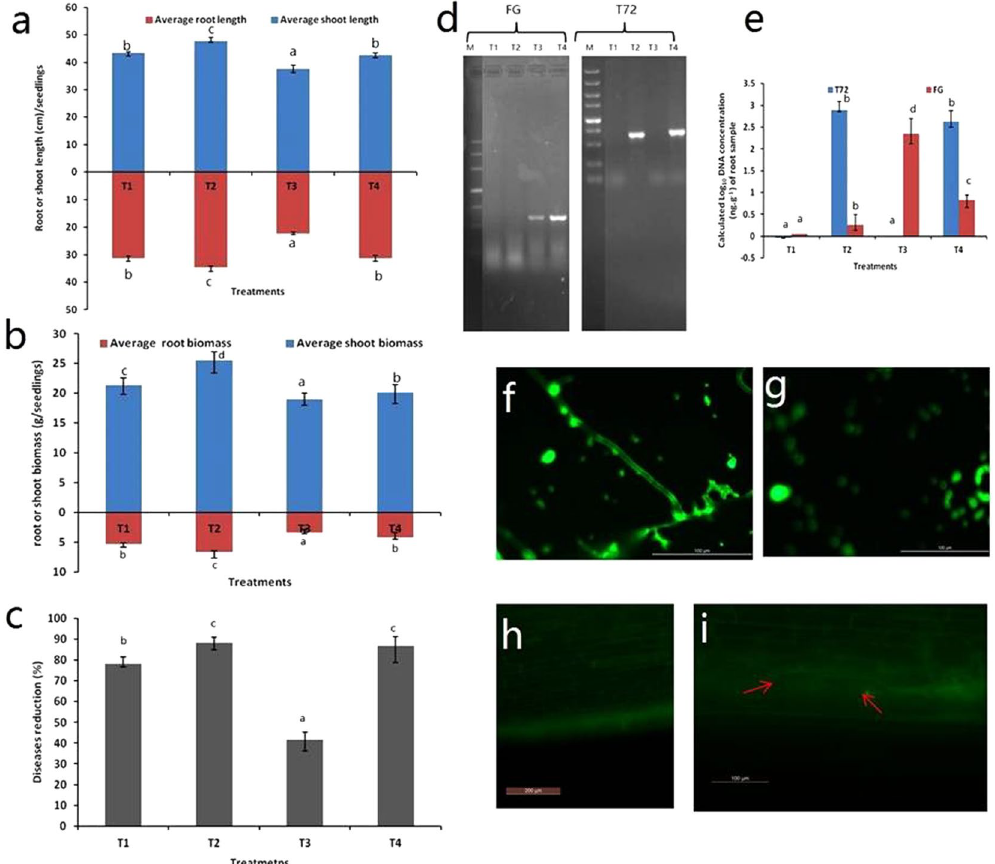
Figure 2. Analysis of physicological indices and root colonization of Trichoderma in maize root by qPCR and eGFP tagged T. harzianum strain CCTCC-RW0024. ( a ) Average root and shoot length (cm/seedlings), ( b ) root and shoot biomass (g/seedlings), ( c ) disease reduction (%), ( d ) electrophoresis representation of T. harzianum strain CCTCC-RW0024 and FG DNA presence in maize root DNA, ( e ) quantification of T. harzianum strain CCTCC-RW0024 and FG DNA in maize root by qRT-PCR, ( f , g ) confirmation of eGFP tagged T. harzianum strain CCTCC-RW0024 by microscopic observation of mycelium and spores respectively. ( h ) Uninoculated maize root control, ( i ) Observation of eGFP tagged T. harzianum strain CCTCC-RW0024 colonization in maize root highlighted in red arrow. (T1 (uninoculated), T2 ( T. harzianum strain CCTCC-RW0024 alone), T3 (FG alone), T4 (Inoculated T. harzianum strain CCTCC-RW0024 and FG). T72- T. harzianum strain CCTCC-RW0024, FG- Fusarium graminearum . Results shown in bar diagram are mean ± S.E.M (n = 3), bars with the same letter are not statistically significant between the treatments following Duncan’s test ( p <